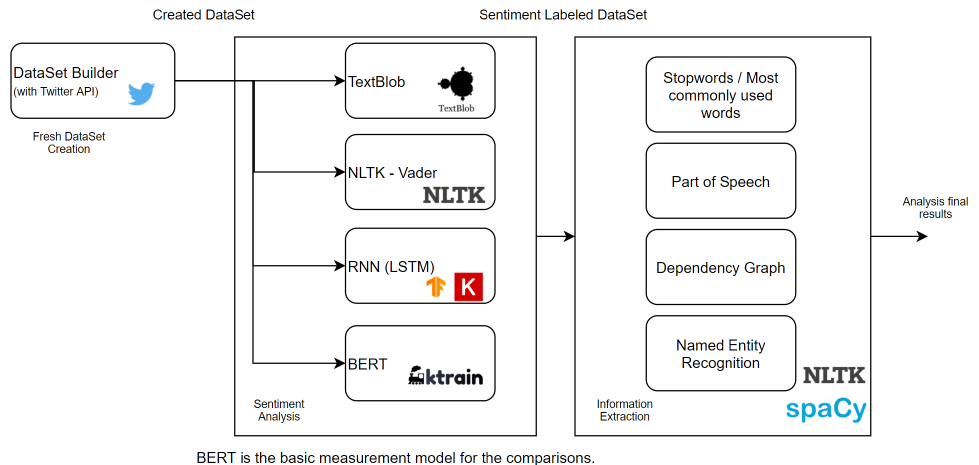
Figure 1. Analysis